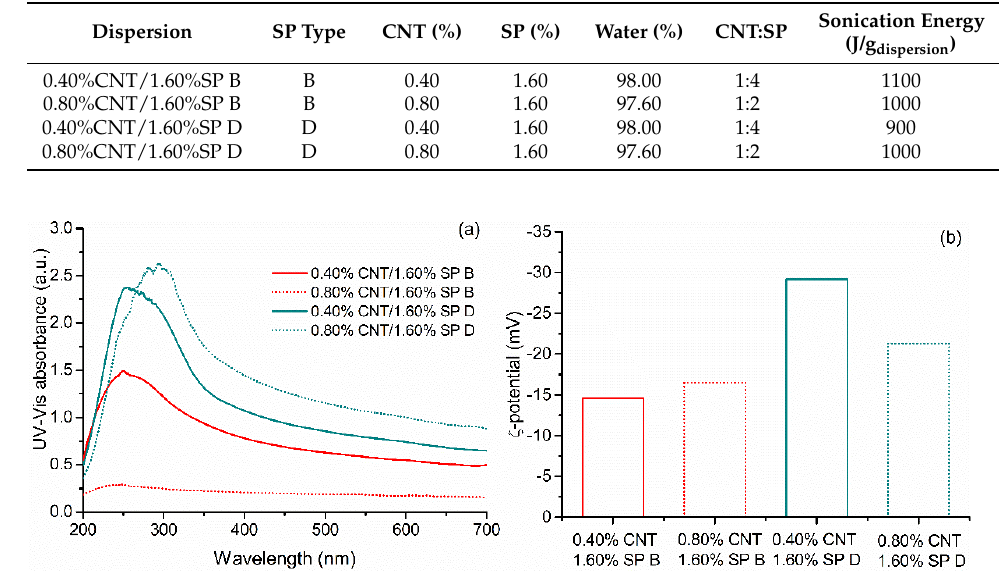
Figure 6. ( a ) UV–Vis absorbance spectra and ( b ) ζ -potential values obtained from different CNT:SP variations using SPs B and D.